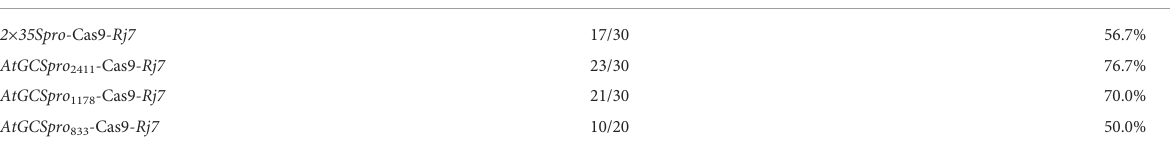
TABLE 1 Comparison of the targeted mutation ef fi ciency in transgenic soybean hairy roots by ARM transformation using different truncated promoters to drive the expression of Cas9 . Cas9 system No. of H/BM roots/ no. of roots